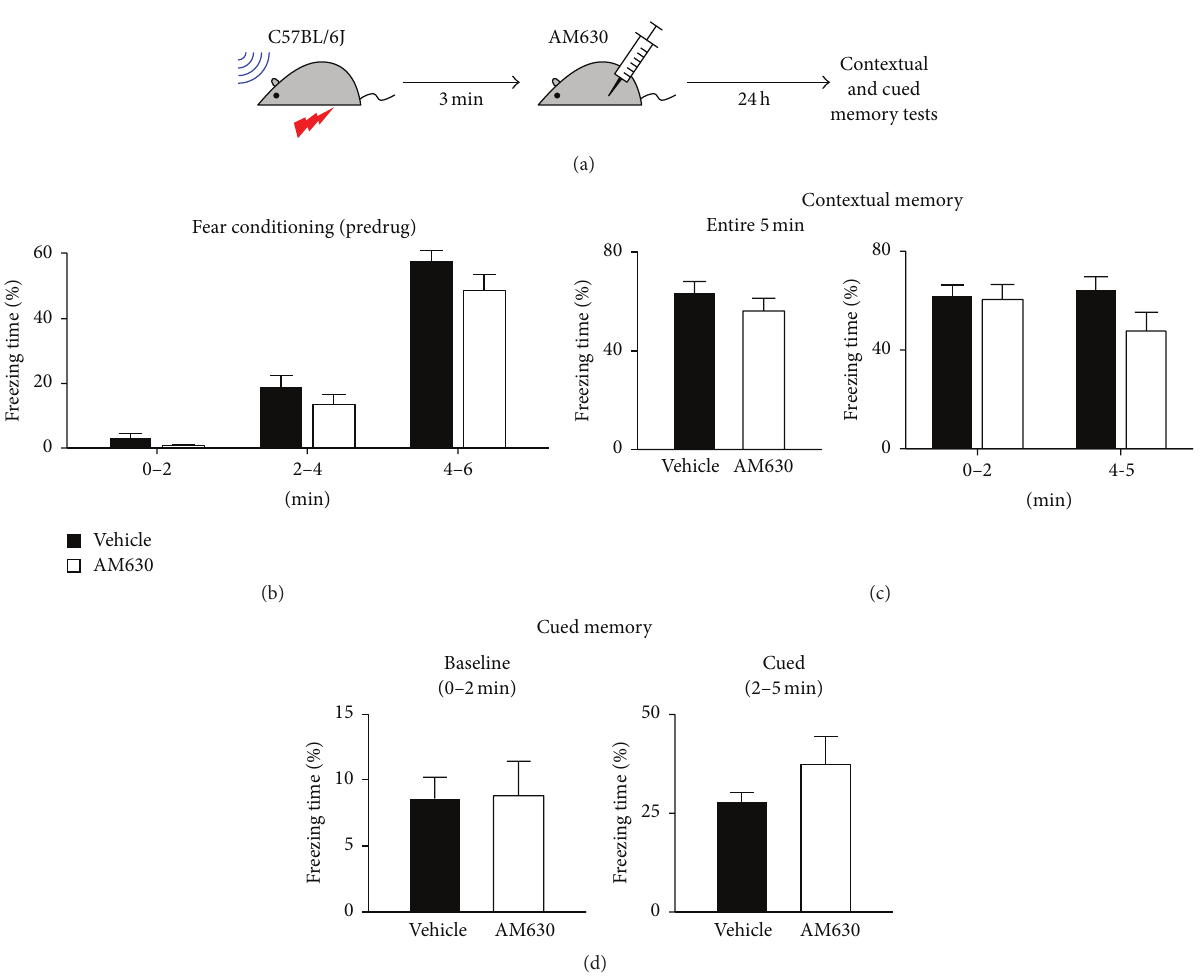
Figure 5: Acute blockade of CB2Rs had little effect on fear memory. (a) Adult male C57BL/6J mice were fear-conditioned with a tone and a footshock, asillustratedinFigure 1(a).Theanimalswereinjected withAM630 (3mg/kg, i.p.),a CB2Rantagonist,3minafter theconditioning. (b) Baseline freezing behavior of mice during the conditioning session. The mice were randomly divided into two groups for injection with AM630 or vehicle. (c) Contextual fear memory of AM630-treated mice was not significantly different from that of control mice. The freezing time was counted during a 5 min session and also analyzed for the first 2 and the last 1min of the session. (d) Cued fear memory was not affected by acute treatment with AM630. A tone was presented for 3min. There was no significant difference in freezing behavior between the two groups either before or during the tone. Error bars represent